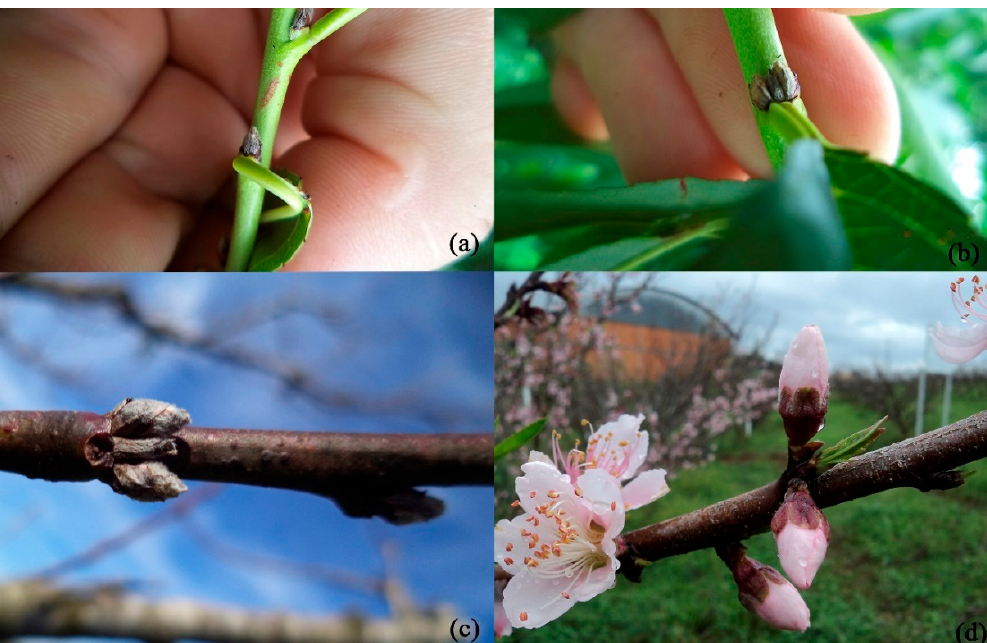
Figure 1. Developmental phases of flower and vegetative buds in peach. ( a ) The onset of flower differentiation; buds are apparent in the leaf axis. ( b ) Differentiated buds before dormancy. ( c ) During dormancy, flower buds remain closed without any apparent change. ( d ) At flowering, the petals open completely, the stigma is receptive, and the anthers dehisce their pollen.